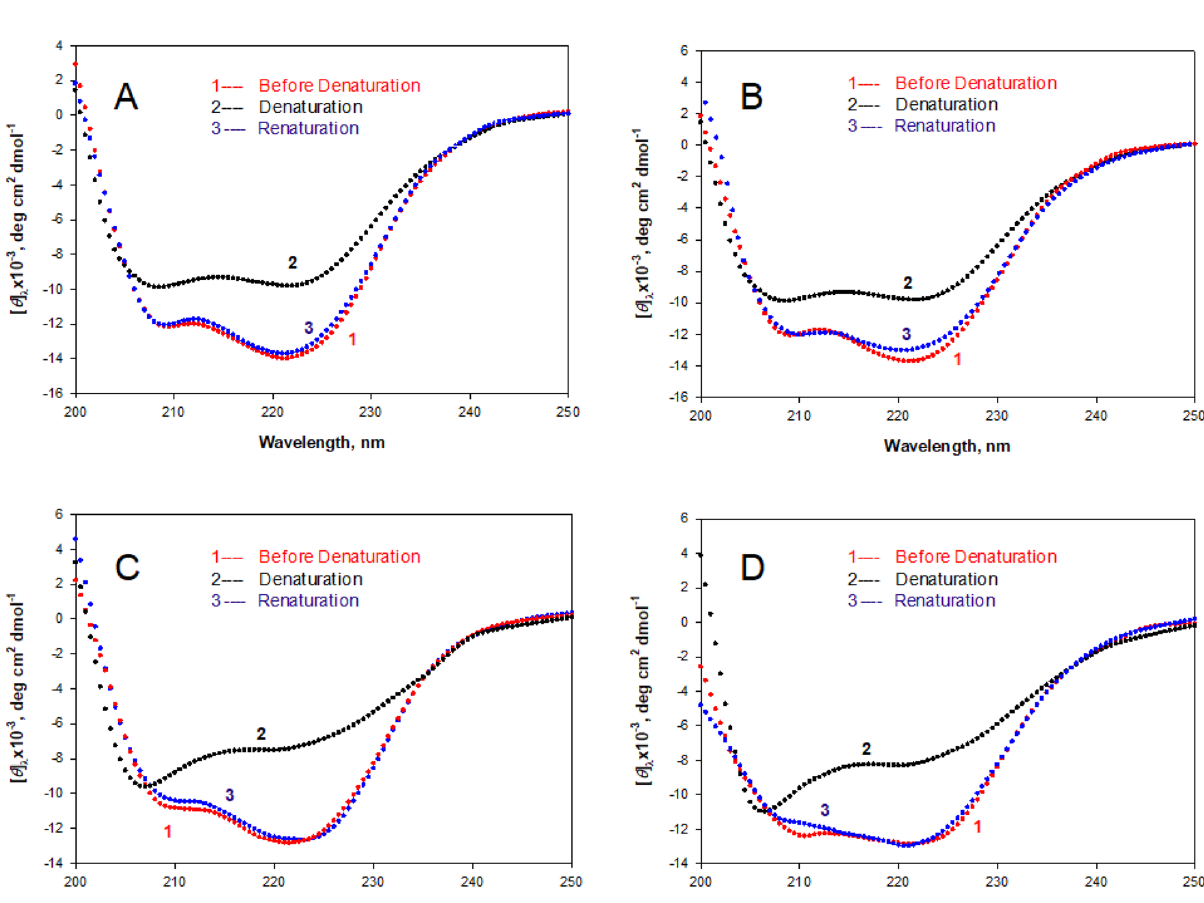
Figure 5. Reversibility of heat-induced denaturation of the labeled and unlabeled WT cyt c and its mutant L94G in the native buffer. Panels A (unlabeled) and B (labeled) show spectra of the unheated native (curve 1), denatured (curve 2) and renatured (curve 3) WT cyt c . Panels C (unlabeled) and D (labeled) show spectra of the unheated native (curve 1), denatured (curve 2) and renatured (curve 3) L94G